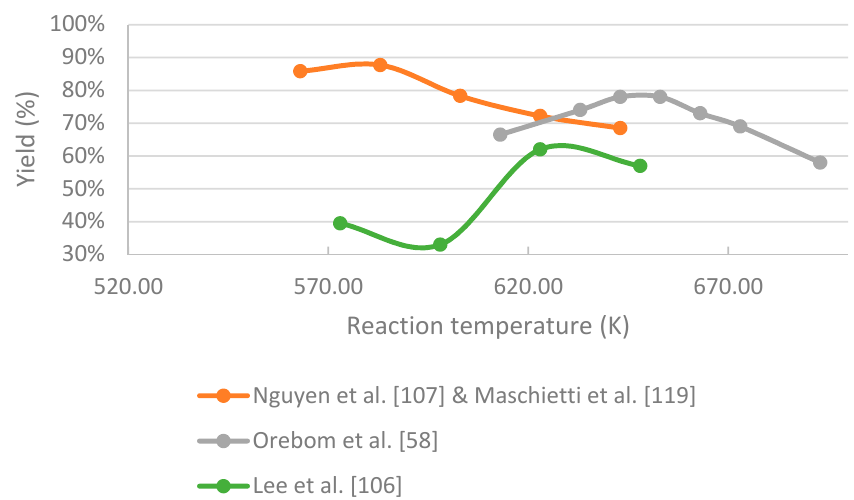
Figure 7. Mass yield of bio-oil as a function of operating temperature. The curves are guides to the eye.